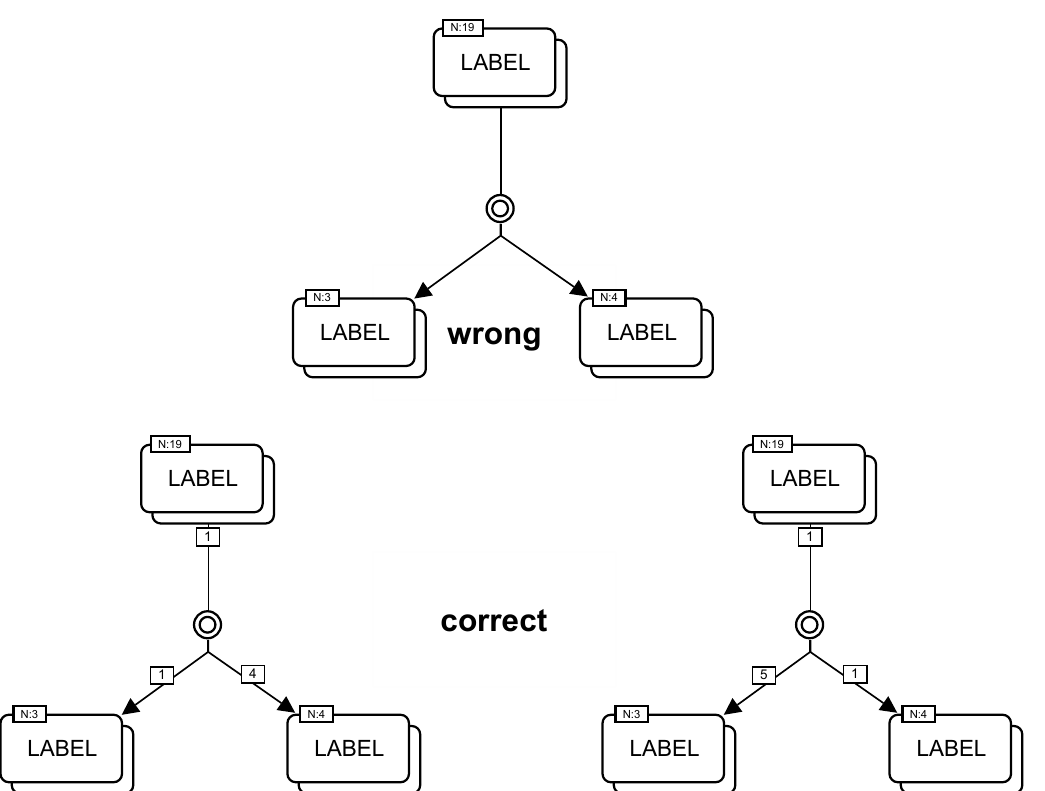
Figure 2.40: Cardinality for production arcs. The process on the top is wrong as the stoi- chiometry is not represented, which leads to